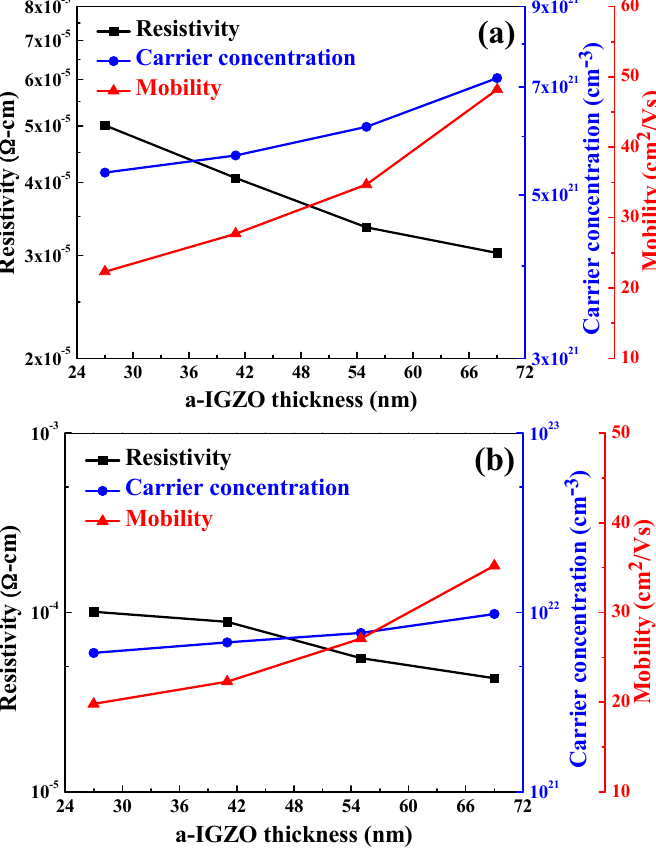
Figure 9. Resistivity, Hall mobility, and carrier concentration of the α -IGZO/Ag/ α -IGZO triple-layer structure as a function of thickness of IGZO film. On ( a ) glass substrates; and ( b ) PET substrates.